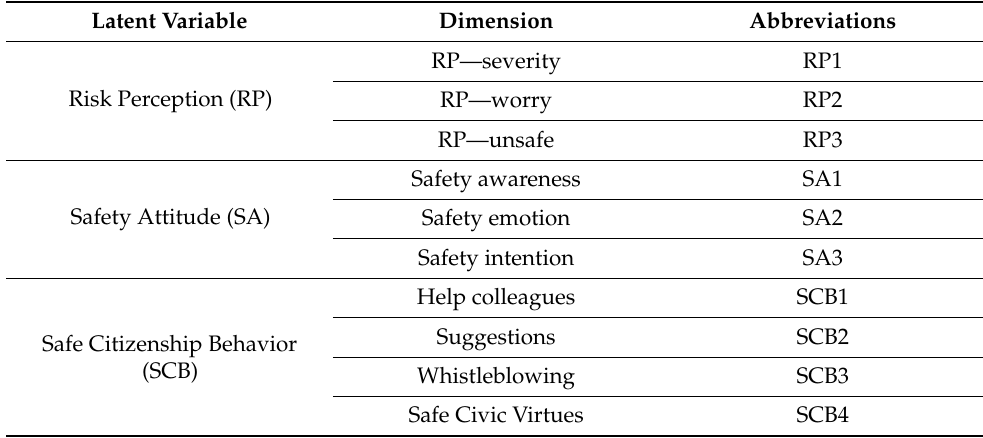
Table 1. Dimension division and abbreviations of risk perception, safety attitude and safety citizen- ship